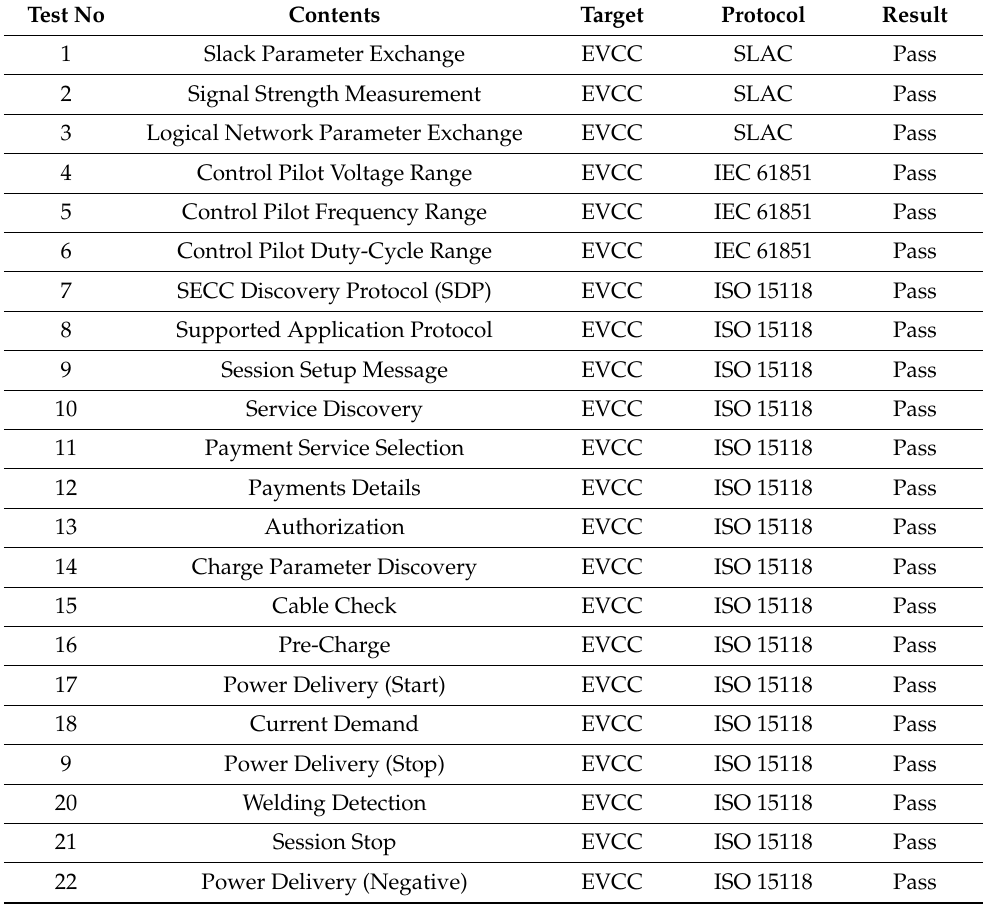
Table 8. The communication testing result with full stack ISO 15118 during V2G